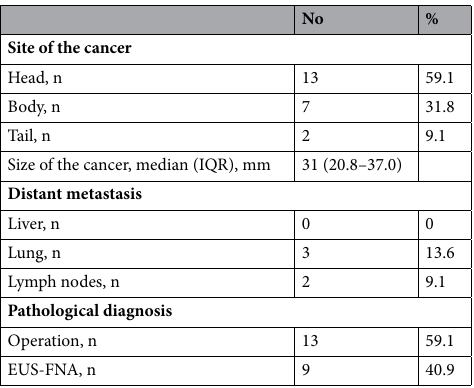
Table 1. The site, size, metastasis site and pathological diagnostic modality of pancreatic cancer. IQR interquartile range, EUS-FNA endoscopic ultrasound-guided fine needle